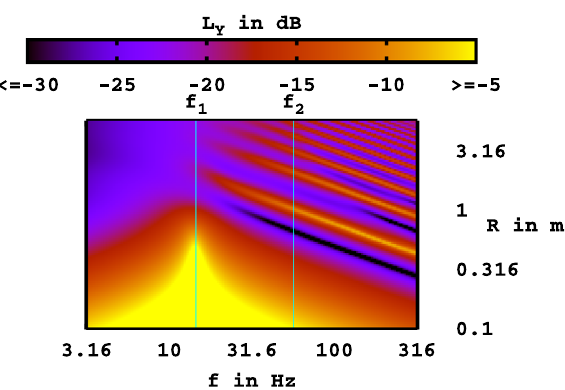
Figure 21. Level of admittance L Y according to (56); cyan marker lines for f 1 and f 2 ; r = 1.0 (cid:5) 10 6 Pa s/m 2 ; large blank upper right corner due to numerical instability.